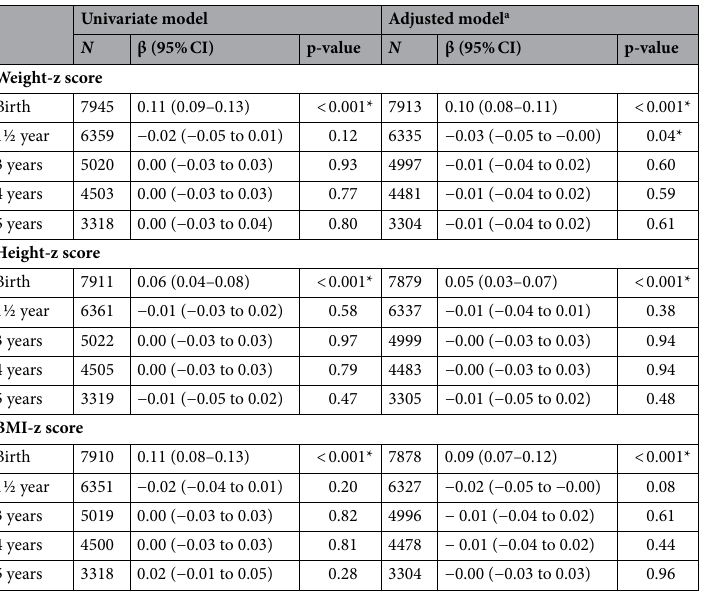
Table 3. Associations between growth data expressed as weight z score, height z score and BMI z score from birth to five years of age and highest random capillary blood glucose level during pregnancy. Analyses performed with univariate and multivariate linear regression. Sex and age independent standard deviation scores (z-scores) were calculated using the Swedish reference population. N number of observations, β β-value, country of birth, parity, smoking at first visit at maternal health care and/or in pregnancy week